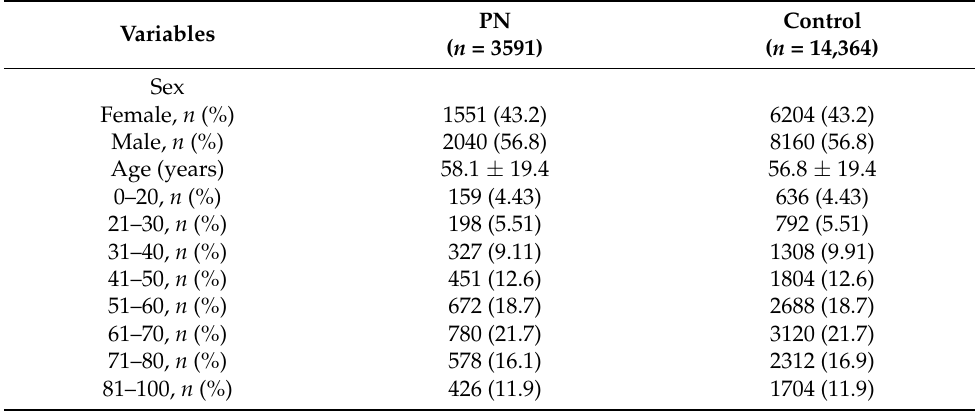
Table 2. Demographic characteristics of the PN and control populations.